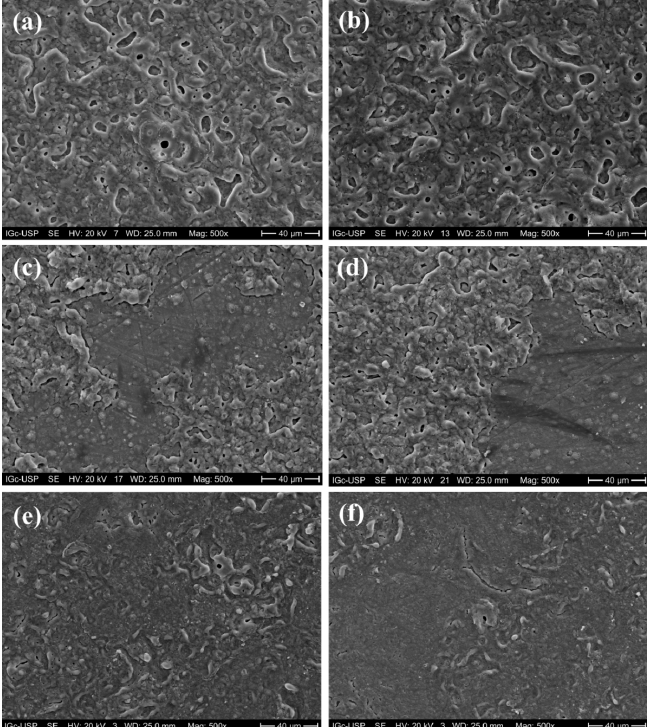
Figure 4. SEM micrographs (secondary electrons mode) showing the surface morphologies of the anodized layers: a) SI-20; b) SI-30; c) PHO-20; d) PHO-30; e) BO-20; e) BO-30.